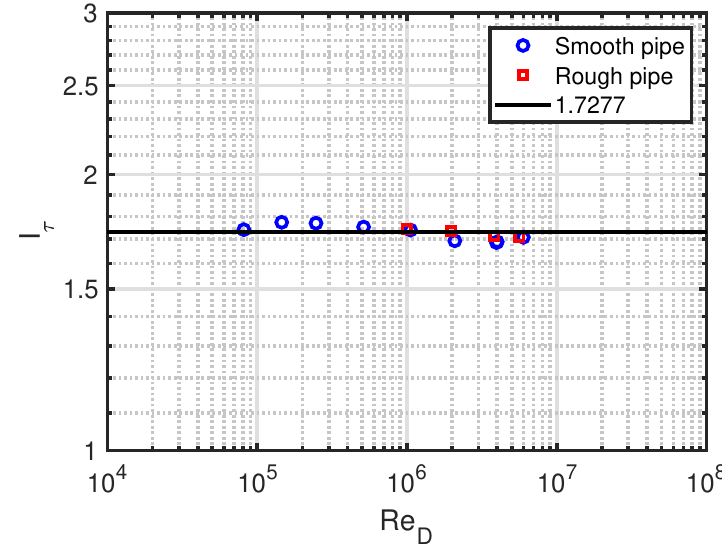
Figure 3. I τ as a function of Re D